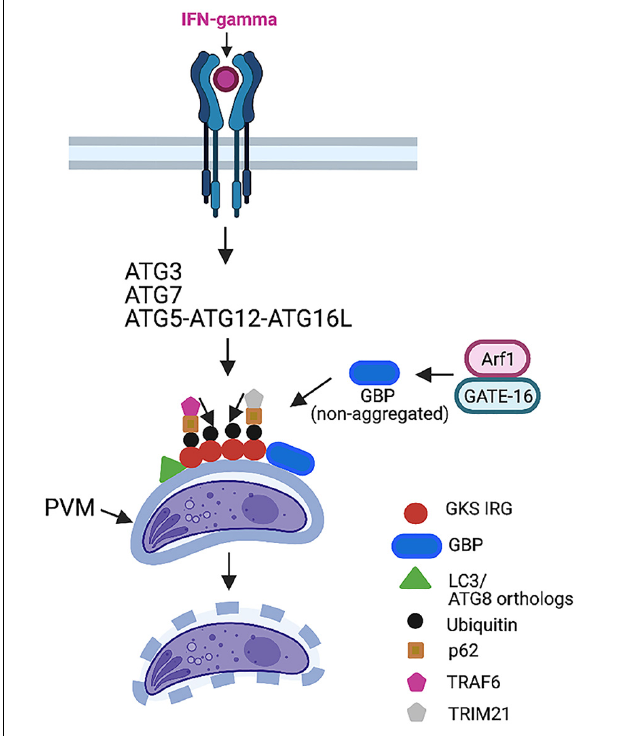
FIGURE 4 | IFN- γ -induces killing of type II and III strains of T. gondii in mouse cells. IFN- γ triggers recruitment of GKS IRGs to parasitophorous vacuole membrane (PVM), a process that requires ATG3, ATG7, and ATG12–ATG5–ATG16L. LC3 and ATG8 orthologs are recruited to PVM. IRGs promote deposition of ubiquitin, p62, and the E3 ubiquitin ligase TRAF6. p62 and TRAF6 further promote sustained decoration of PVM with ubiquitin. This process leads to delivery of GBPs to PVM. The end result is disruption of PVM and death of parasite. TRIM21 is another E3 ubiquitin ligase recruited by p62 that promotes ubiquitination. However, it does not seem to drive vesiculation of PVM. GATE-16 activates Arf1, enabling GBP to remain in a non-aggregated form, thus promoting GBP loading onto PVM. This process does not occur in cells infected with type I strains of T. gondii because ROP5/ROP18/GRA7 inactivate IRGs preventing their loading onto PVM. Figure was generated using